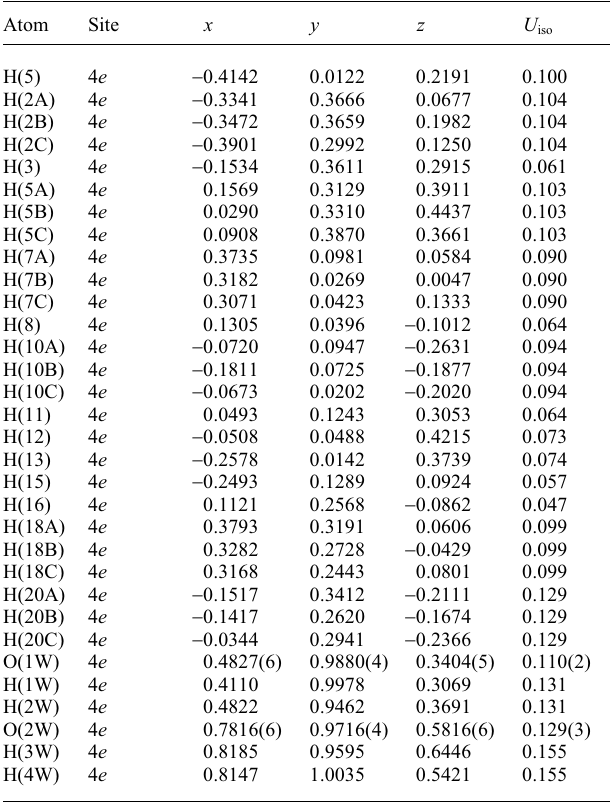
Table 2. Atomic coordinates and displacement parameters (in Å 2 )